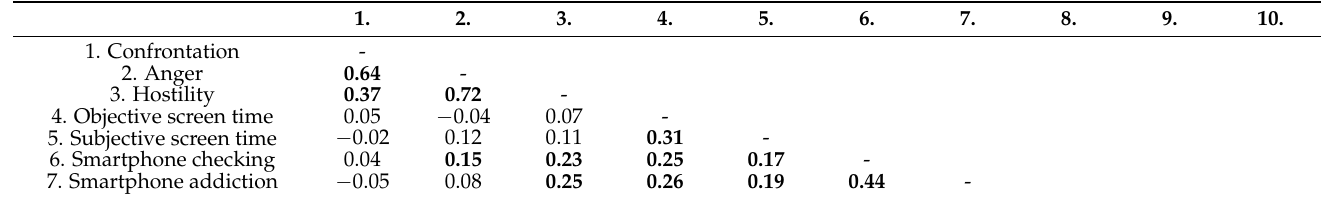
Table 2. Pearson Correlations between